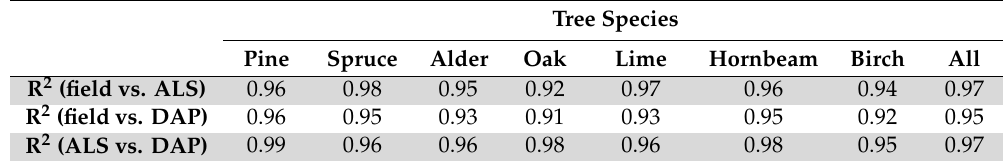
Table 6. Regression analysis of the tree heights derived from all methods applied in this study. measurements.